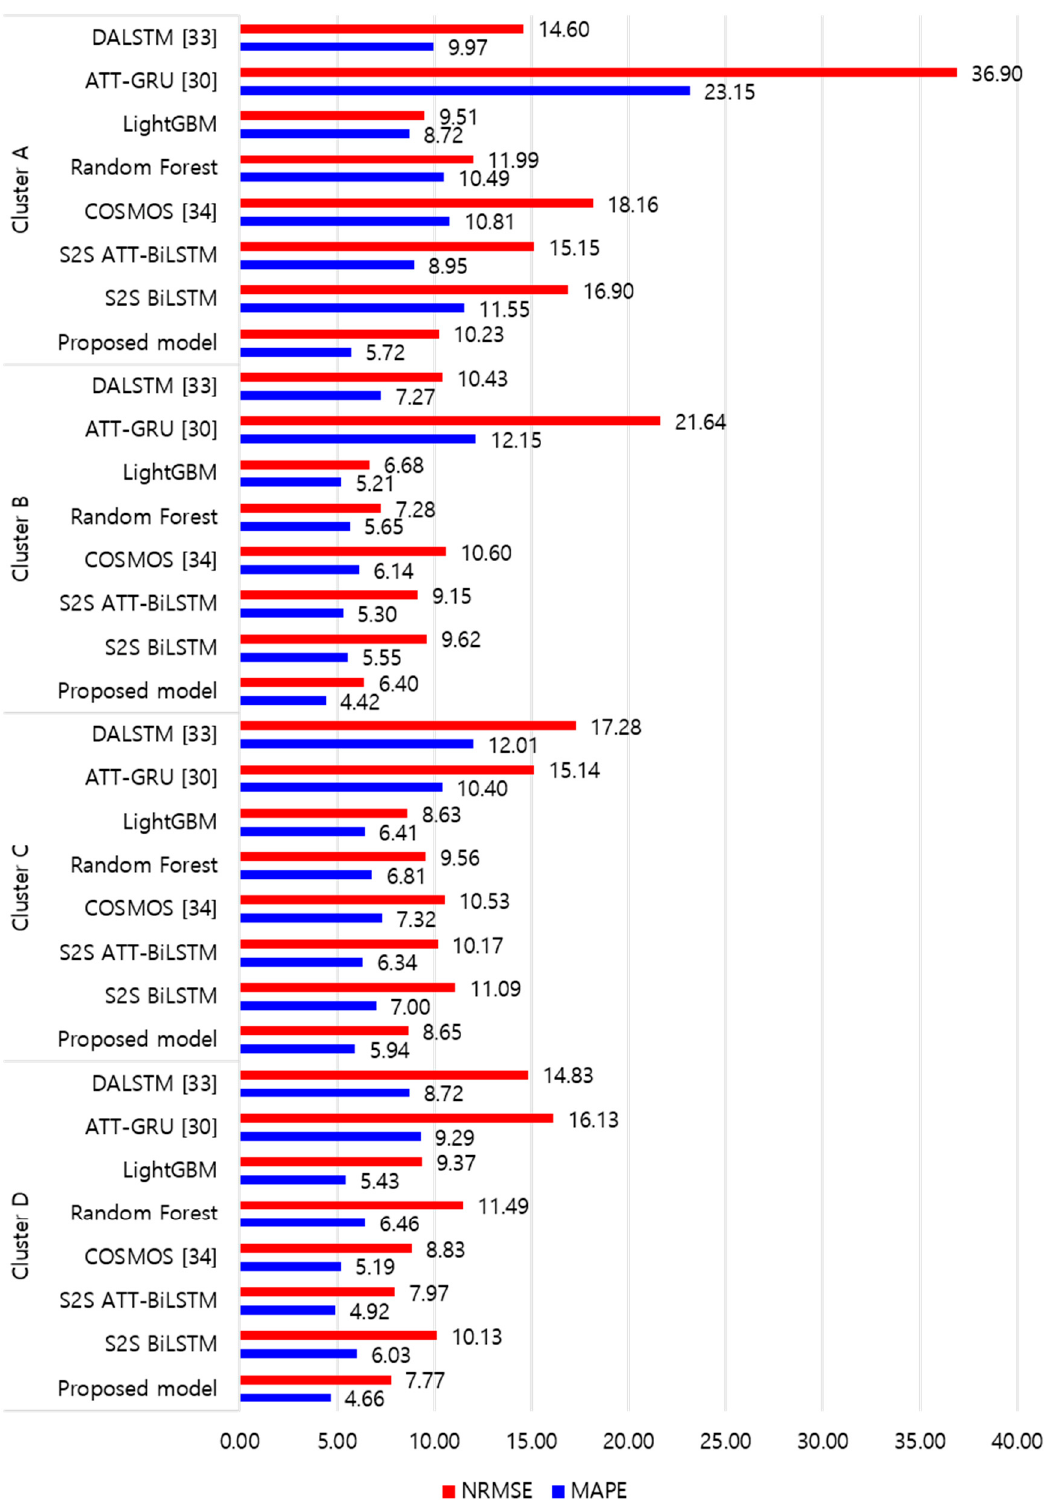
Figure 9. Average of NRMSE and MAPE for each model (%).